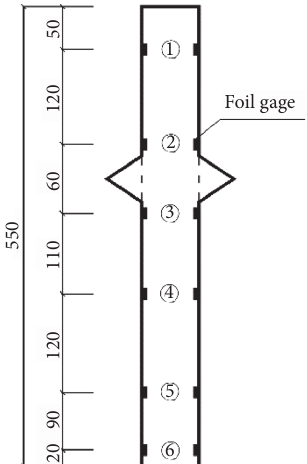
Figure 6: The layout plan of the axial measuring